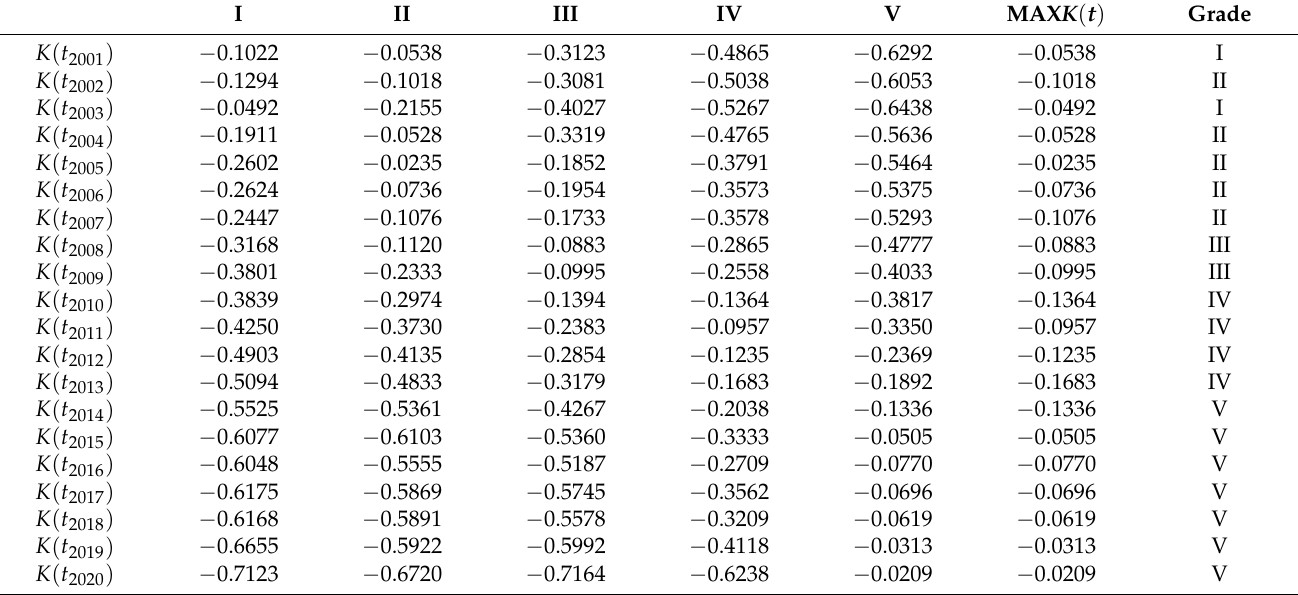
Table A1. Comprehensive correlation degrees and grades of China’s food security during 2001–2020.